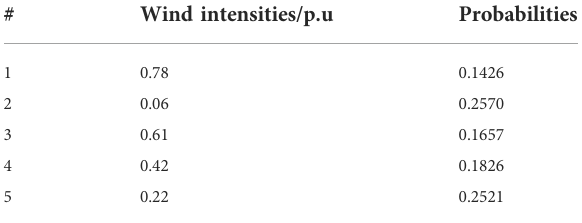
TABLE 1 Wind scenarios. # Wind